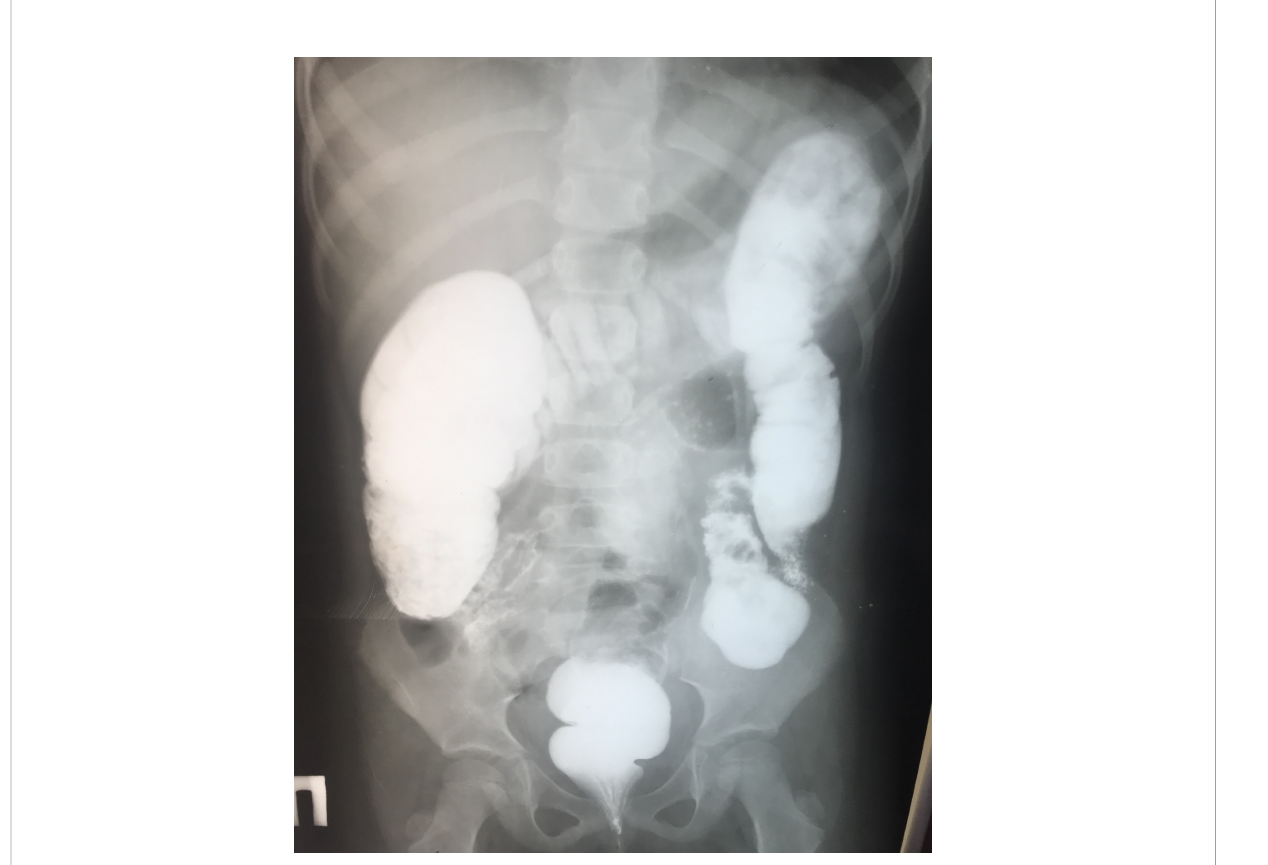
FIGURE 2 Irrigography by using contrast barium enema revealed dolichocolon at the age of 5 years.